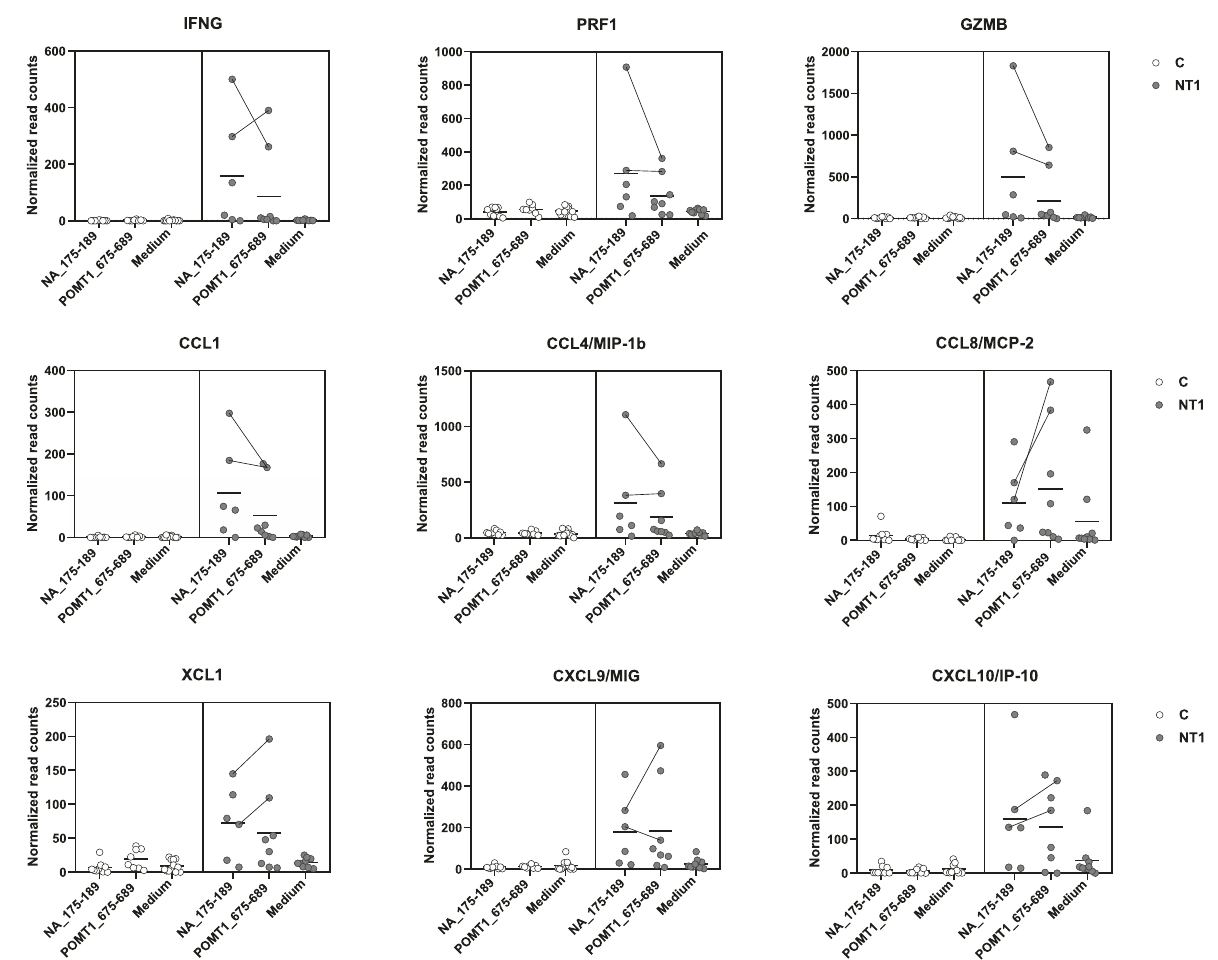
Fig. 7 T cell-related genes differentially expressed in peptide-stimulated PBMC from Pandemrix-associated NT1 patients (RNA-seq). Dot plots demonstrating the expression levels (normalized read counts) of nine T cell-related genes showing signi fi cant differences in expression (** p < 0.01) between NT1 patients and controls either after stimulation with NA 175 – 189 or POMT1 675-689 peptides (compare Fig. 6). Differentially expressed genes were identi fi ed using edgeR, based on a test analogous to Fisher ’ s exact test. The paired method was used for comparisons, calculating 2-sided p -values and adjusting for multiple testing using BH correction. The lines indicate paired data of two strong responders, NT1 patients P003 and